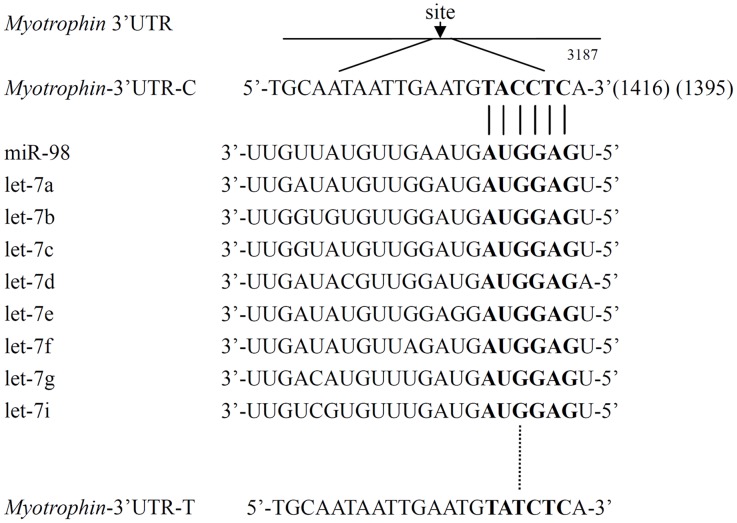
The myotrophin rs17168525 C/T variant occurs in the let-7/miR-98 binding site.The variant rs17168525 is a C to T change (mRNA sequence as reference) located in the predicted binding site for let-7/miR-98 in the 3′-UTR of the myotrophin gene. C-allele at rs17168525 base-paired with G in Watson—Crick mode (shown with a solid line). However, when the T-allele is present, base-pairing complementarity is interrupted (shown with a dashed line).